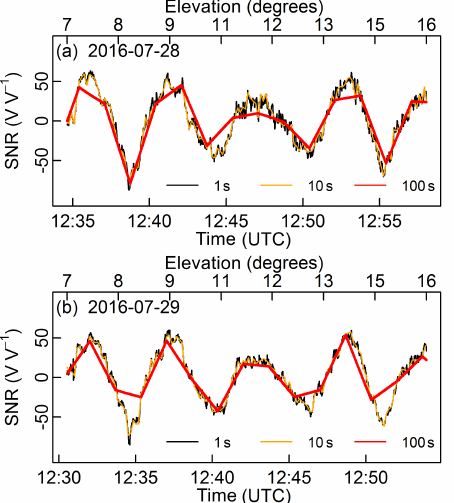
Figure 10. Two examples of L2C SNR data sets (from the GPS PRN 10 ascending tracks) acquired by the 3.3m antenna at two contigu- ous dates: (a) 28 July and (b) 29 July 2016. SNR data with three different sampling intervals at 1, 10 and 100s are shown in black, orange and red lines, respectively.